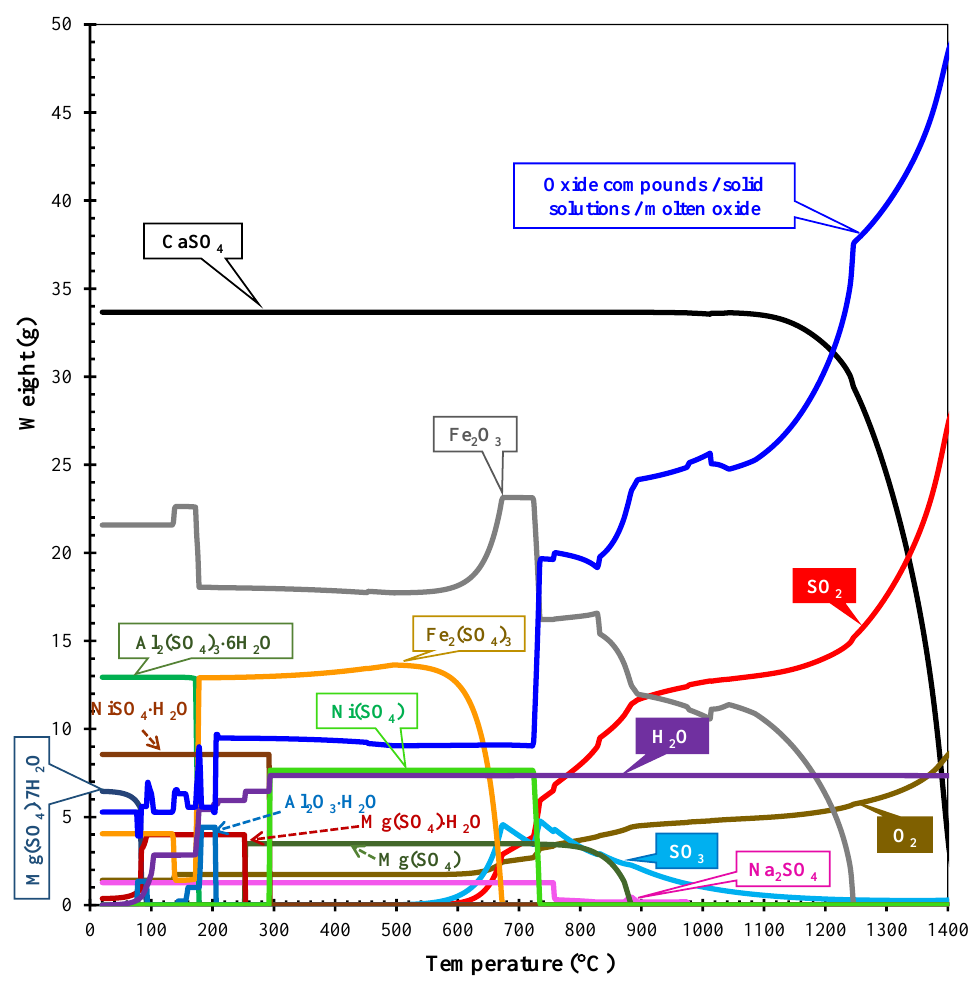
Figure 3. Thermochemical calculation by FactSage during the heating of 100 g of natrojarosite resi- due.